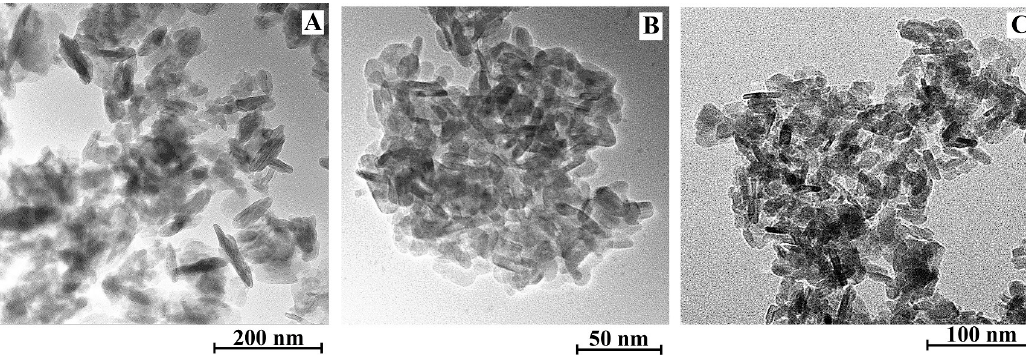
Figure 3. Transmission electron microscopic (TEM) images of the CuS prepared in different systems. ( A )